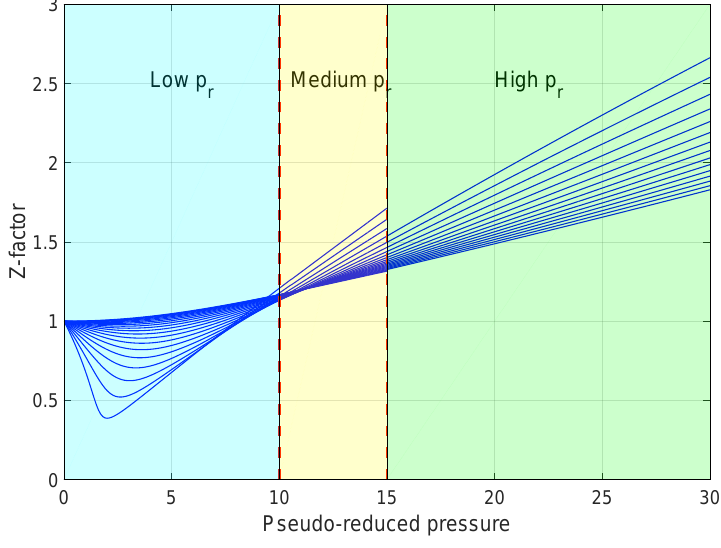
Figure 3. The standard S-K chart and its extension to high reduced